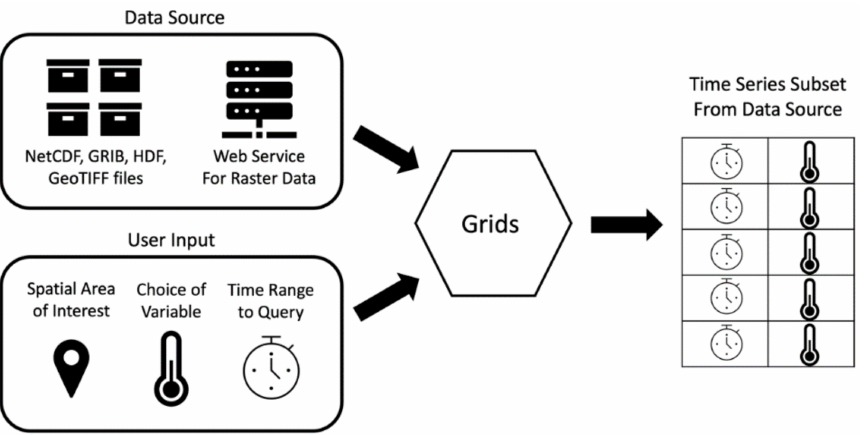
Figure 1. Grids Python Package